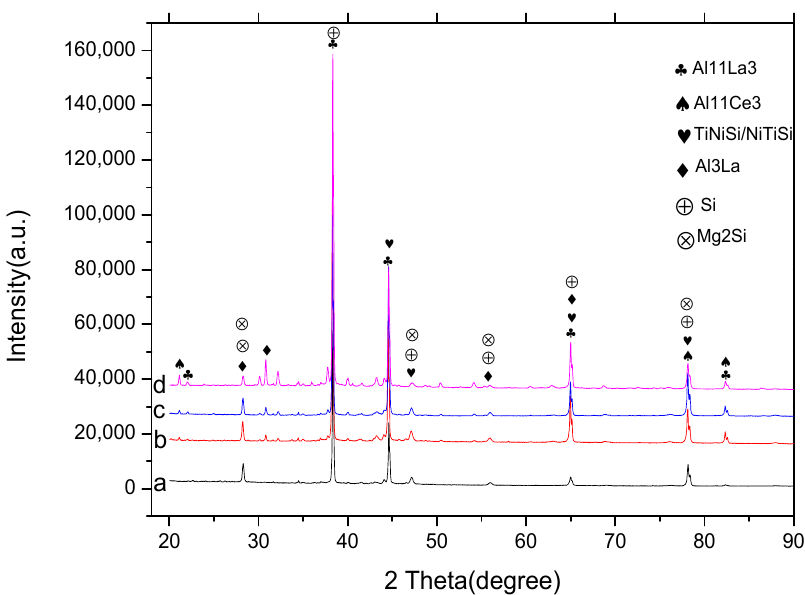
6 of 15 Figure 2. X-ray image showing no significant presence of porosity. 3.2. Microstructural Characteristics The results from the XRD analysis are shown in Figure 3. Ce and La’s addition changes the peaks present, but the actual determination is difficult due to many overlaps. The baseline Figure 3a is the XRD spectrum for the alloy without Ce and La additions providing the lines for Si and Mg 2 Si. The addition of Ce and La adds new lines near 20°, 30°, and just below 80°. These lines are associated with Al 11 Ce 3 , Al 11 La 3 , and Al 3 La. It